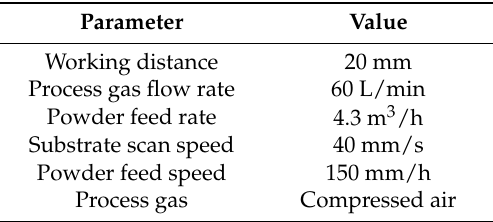
Table 1. Coating parameters of the plasma